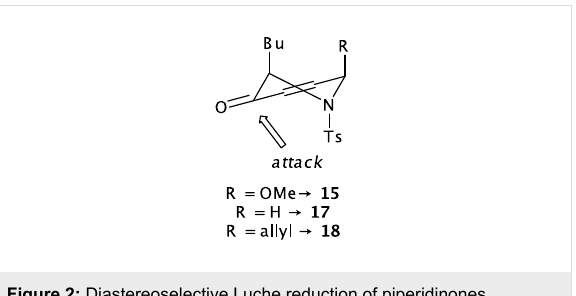
Figure 2: Diastereoselective Luche reduction of piperidinones